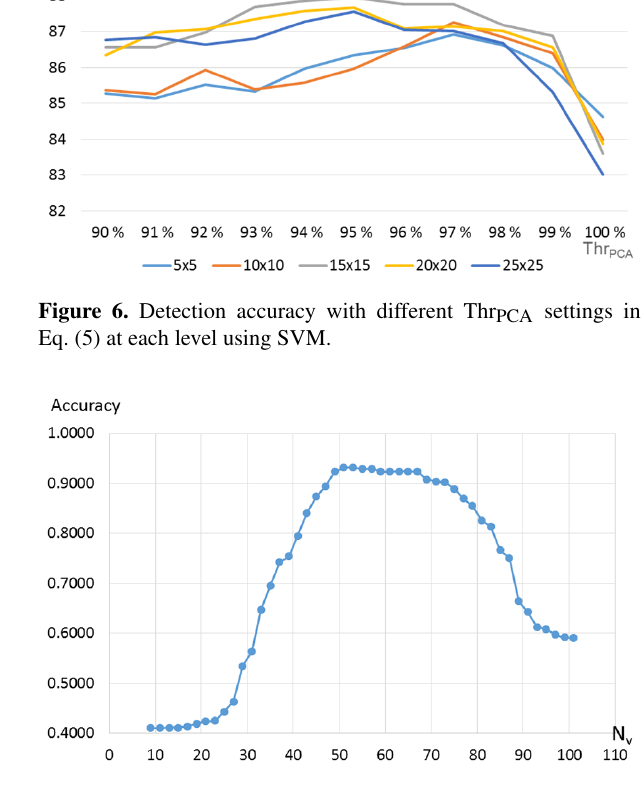
Figure 7. Detection accuracy with different N v